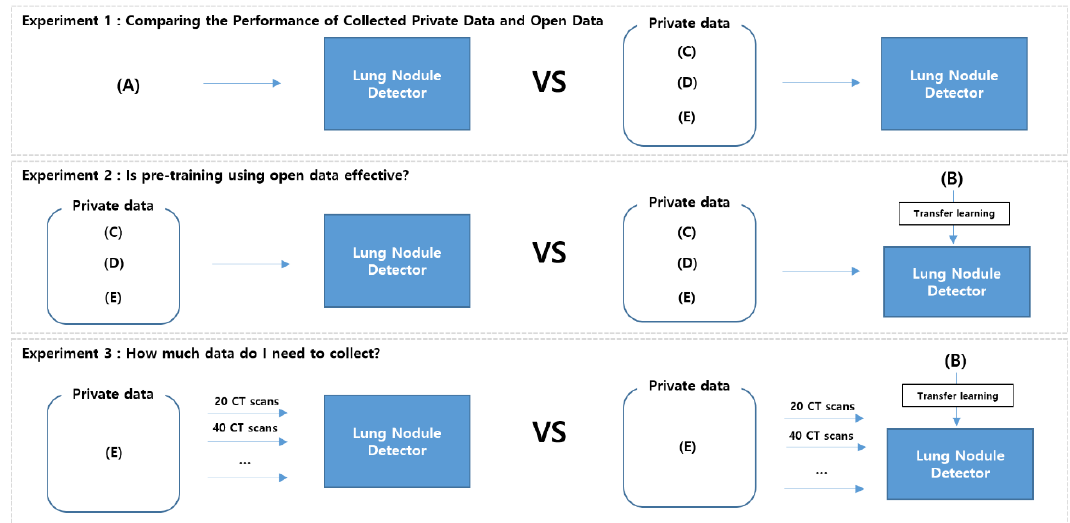
Figure 5. Experimental settings.